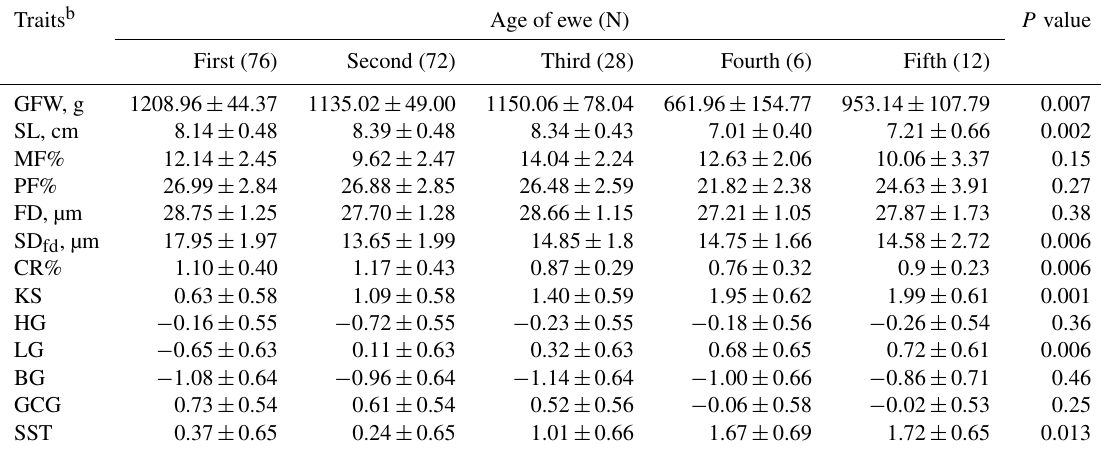
Table 4. Predicted least-square means and standard errors of the effect of age of ewe on the studied wool traits in Barki sheep a . Traits b Age of ewe (N) P value First (76) Second (72) GFW, g